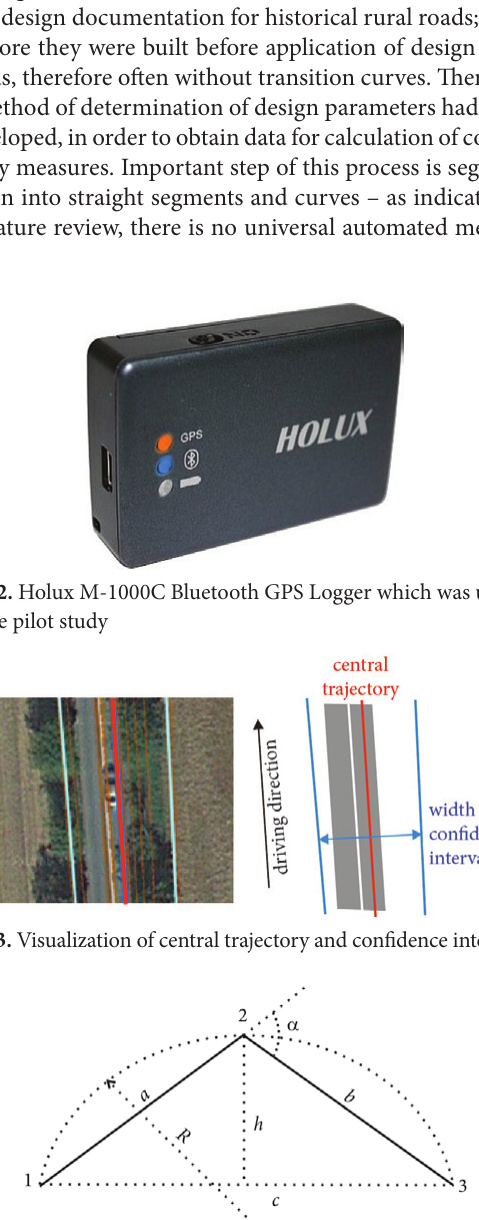
Fig. 4. Scheme of elements used in the calculation of